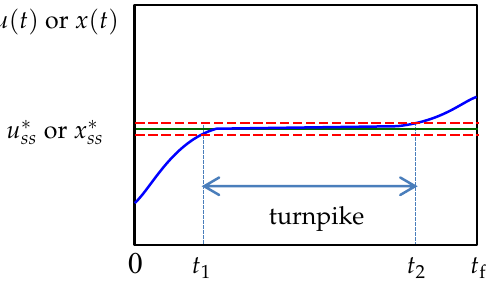
Figure 1. An optimal control or state trajectory with two transient phases and a turnpike in between. The green solid line represents the (globally) optimal steady state u ∗ ss or x ∗ ss , and the red dashed lines denote its ǫ -neighborhood.